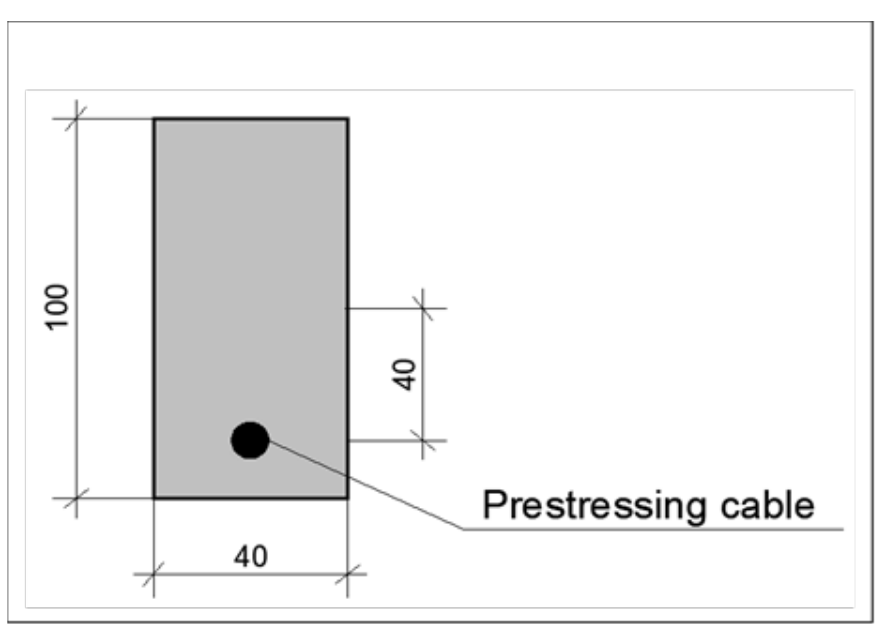
Figure 7. Prestressed cross section, measured in